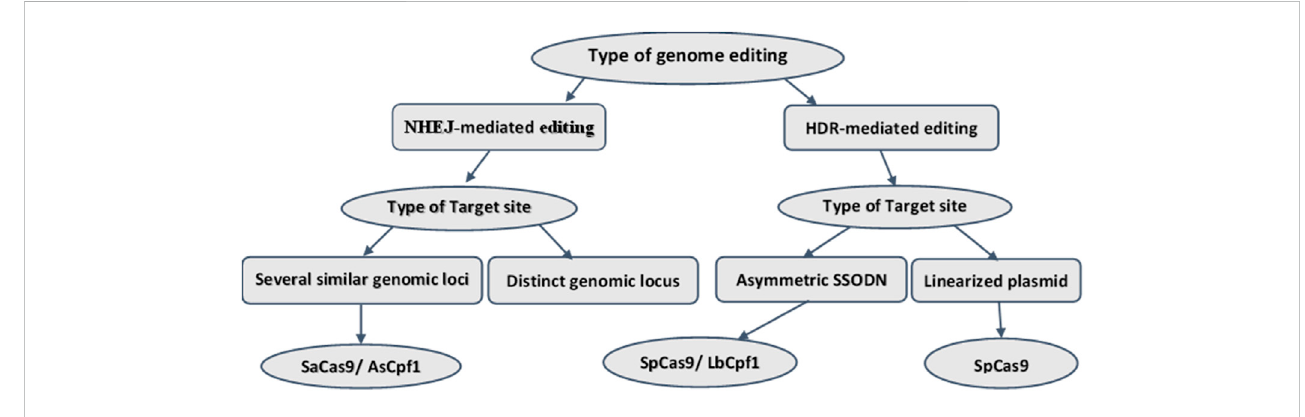
FIGURE 3 Selection of Cas